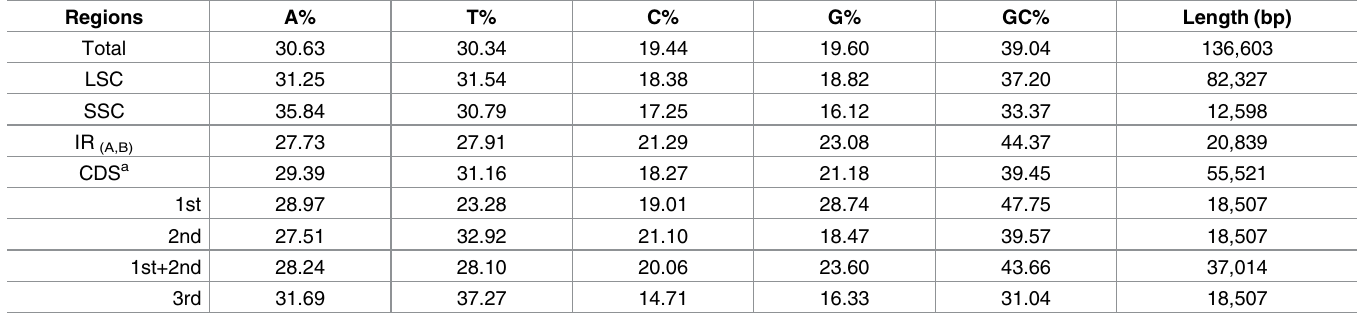
LSC: large single-copy region; SSC: small single-copy region; IR: inverted repeat; CDS: protein-coding region.